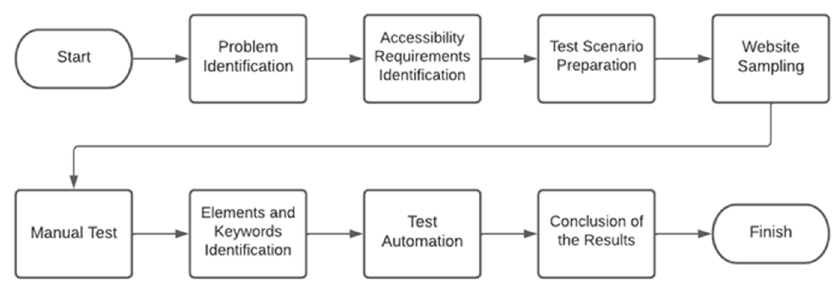
Figure 1. Research Figure 1. Research workflow.